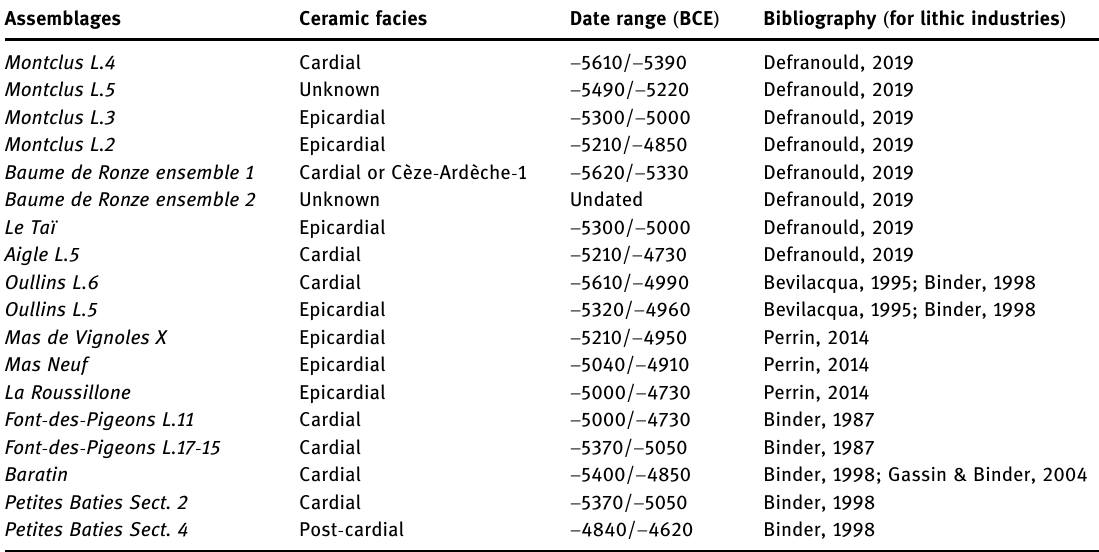
Table 1: Lithic assemblages directly studied and comparative assemblages Assemblages Ceramic